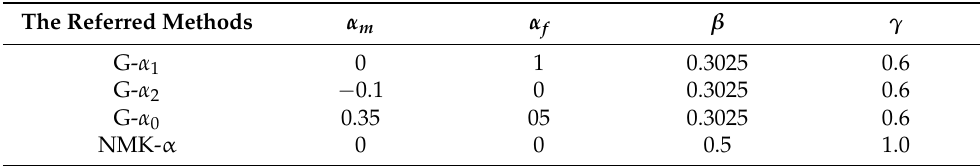
Table 1. Selected parameters for the referred methods.